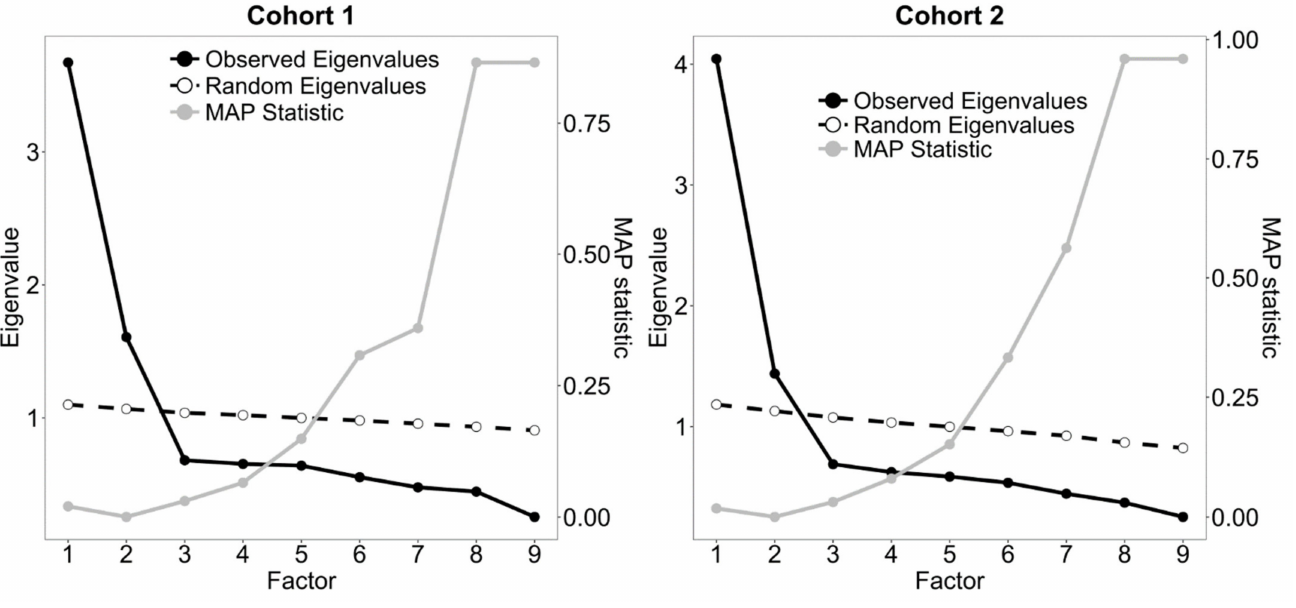
Figure 2. Scree-, parallel analysis, and minimum average partial (MAP) correlation statistic plots for the Work Annoyance Scale in the two cohorts (Cohort 1 n = 2226; Cohort 2 n = 655). The results of the ESEM analysis showed an optimal fit for the two-factor model (Cohort 1: CFI = 0.984, TLI = 0.970, RMSEA = 0.049 [0.040, 0.059], SRMR = 0.017; Cohort 2: CFI = 0.990, TLI = 0.980, RMSEA = 0.040 [0.023, 0.061], and SRMR = 0.018). The